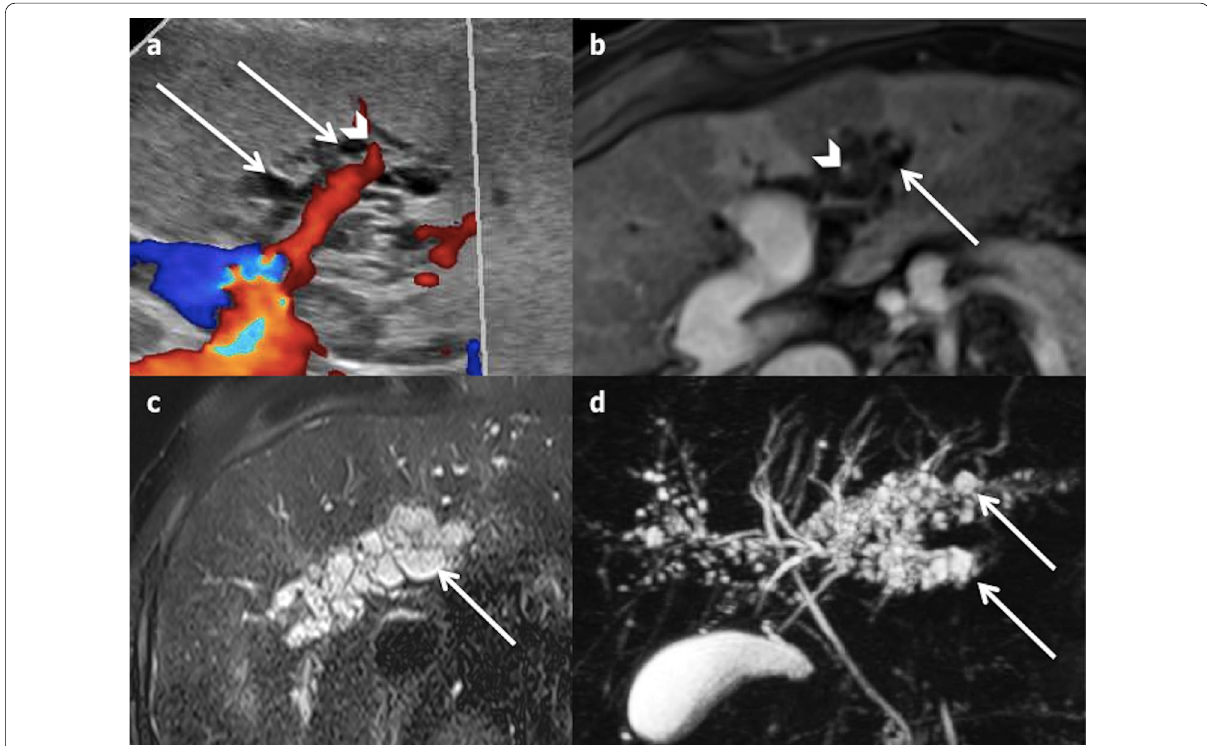
Fig. 16 Peribiliary cyst in a 69-year-old cirrhotic male. a Ultrasonography shows multiple periportal (arrowhead) cysts (arrows). b The portal vessels are clearly visible (arrowhead) on axial portal venous phase magnetic resonance imaging, showing the periportal location of the cysts. c and d Axial T2-weighted magnetic resonance imaging and magnetic resonance cholangiopancreatography images show multiple small cysts along thin, non-dilated bile